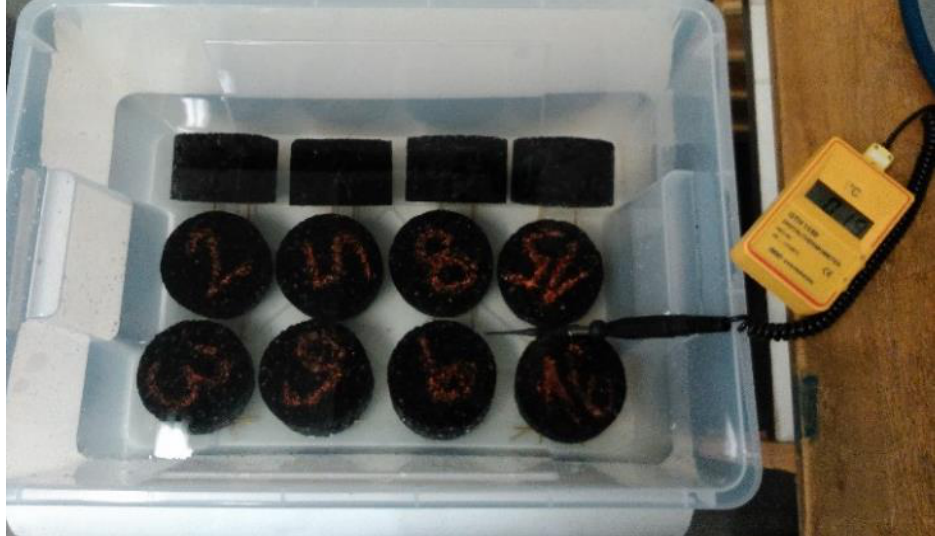
Figure 1. Samples in distilled water before freeze–thaw cycles (Photo: Authors).